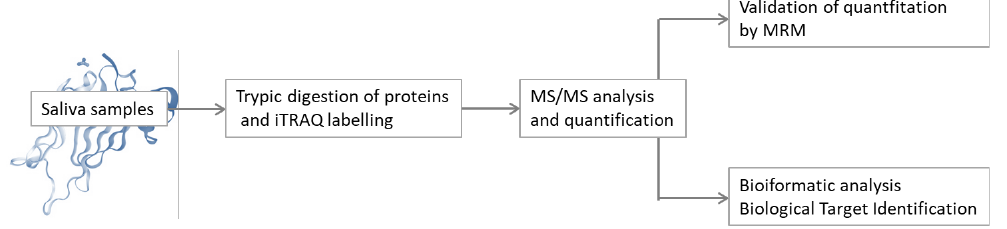
Figure 8. Schematic representation of the proteomic and bioinformatics analysis of saliva [157]. This was not the first research that targeted the proteome of the saliva of people with diabetes. In 2009, Rao et al. [158] identified 65 proteins with different expressions in the saliva of people with type 2 diabetes compared to pre-diabetes patients and healthy volunteers. The characterisation of the salivary proteome was performed using the 2D-LC-MS/MS method, and a quantification was performed without isotope labelling. Tandem